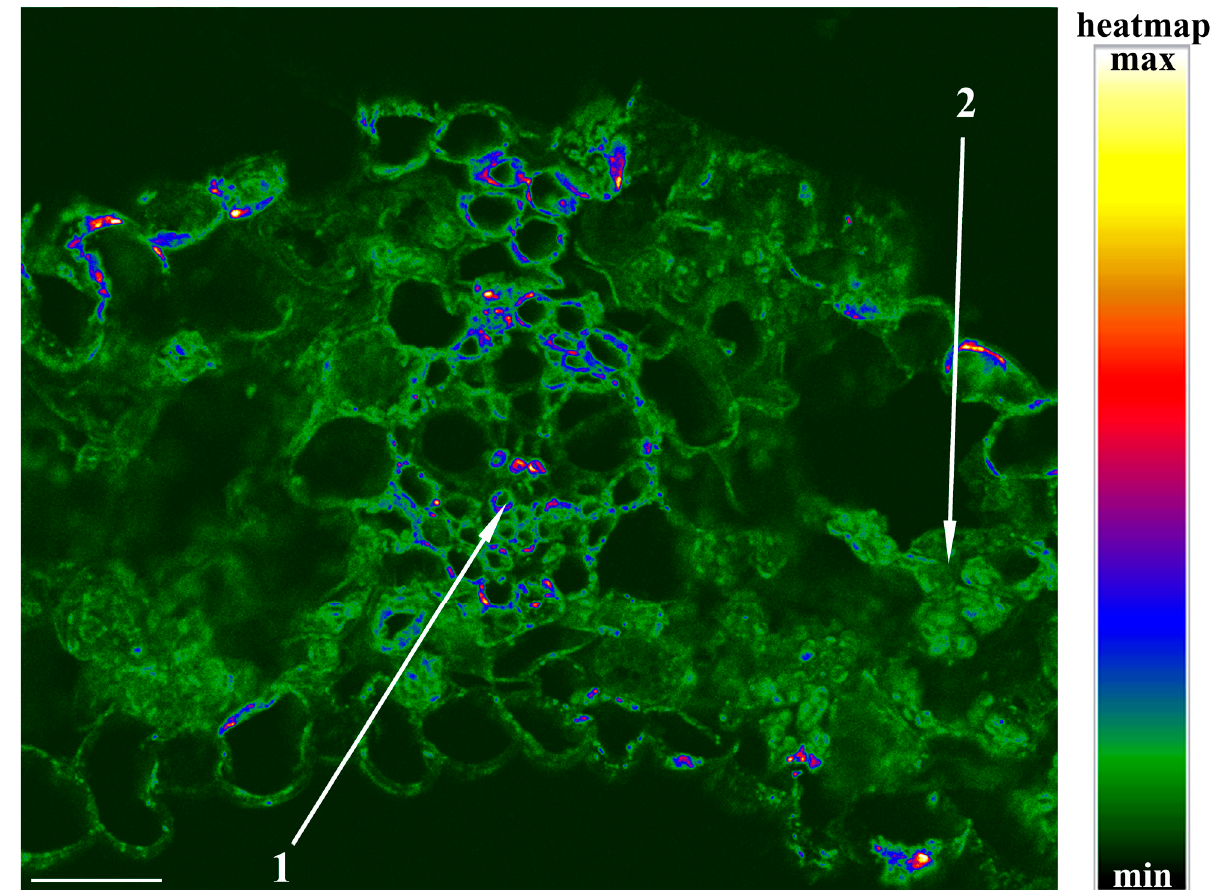
Figure 5. Localization of lignin in berberine-stained leaf cross sections of barley plants: 1—vasculature, 2—mesophyll. Heatmap represents intensity of fluorescence corresponding to lignin depicted by color. Scale 100 µm.